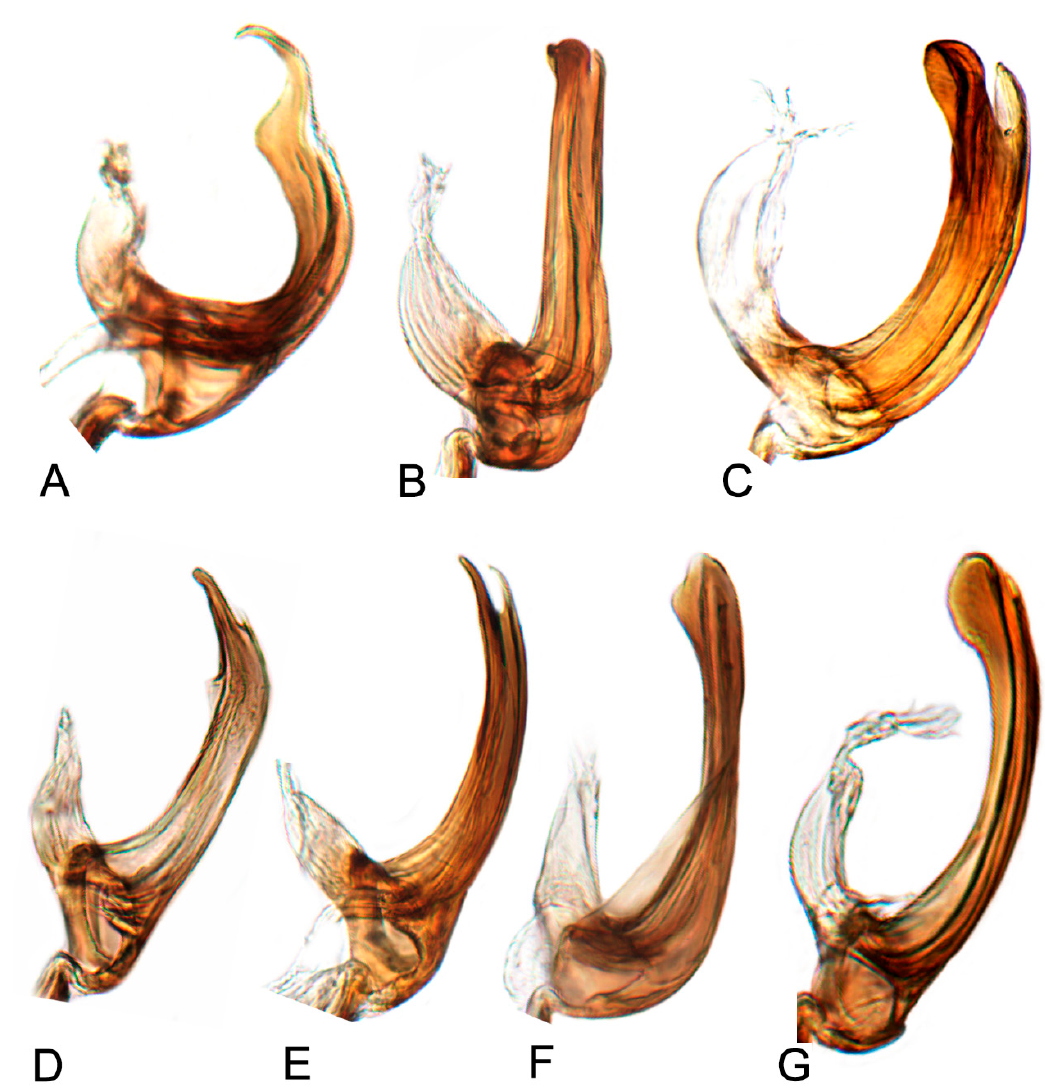
Figure 22. Aedeagus, lateral view. ( A ) H. concavus; ( B ) H. dietrichi ; ( C ) H. bucephalus ; ( D ) H. fletcheri ; ( E ) H. dichotomous ; ( F ) H. sellatus ; and ( G ) H. rectus .